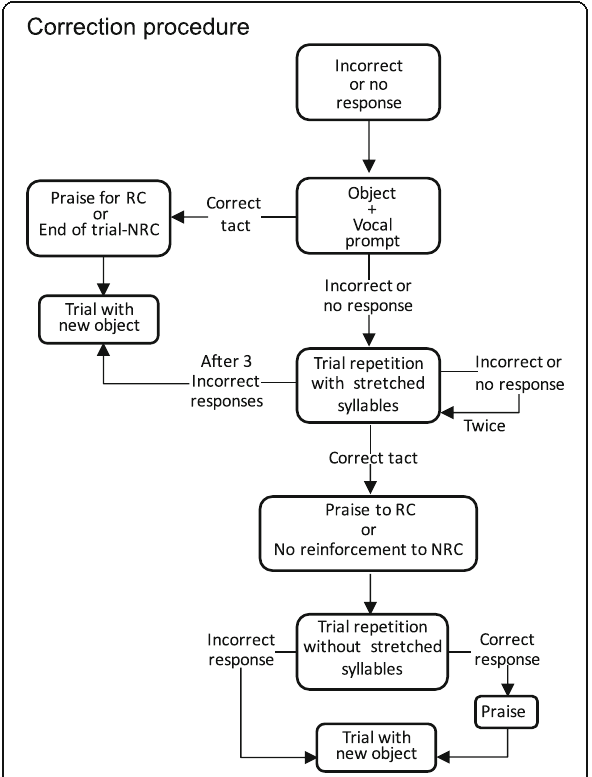
Fig. 2 Correction procedure flowchart. NR = no reinforcement after correction condition. RC = reinforcement after correction